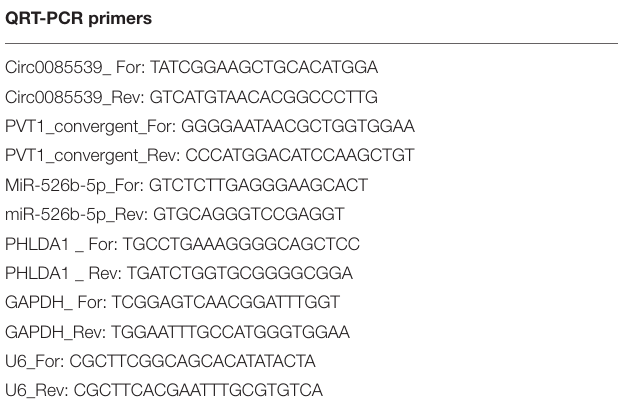
TABLE 2 | Overview of the sequences of all primers used in this study. QRT-PCR